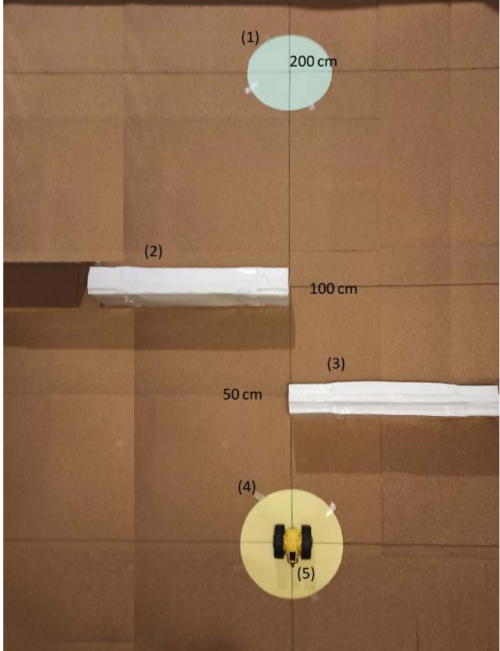
Figure 12. Scenario with two obstacles: (1) goal, (2,3) obstacles, (4) home, and (5) robot. The best motion proposal obtained at the end of 300 generations is simulated. It describes the trajectory shown in Figure 13.